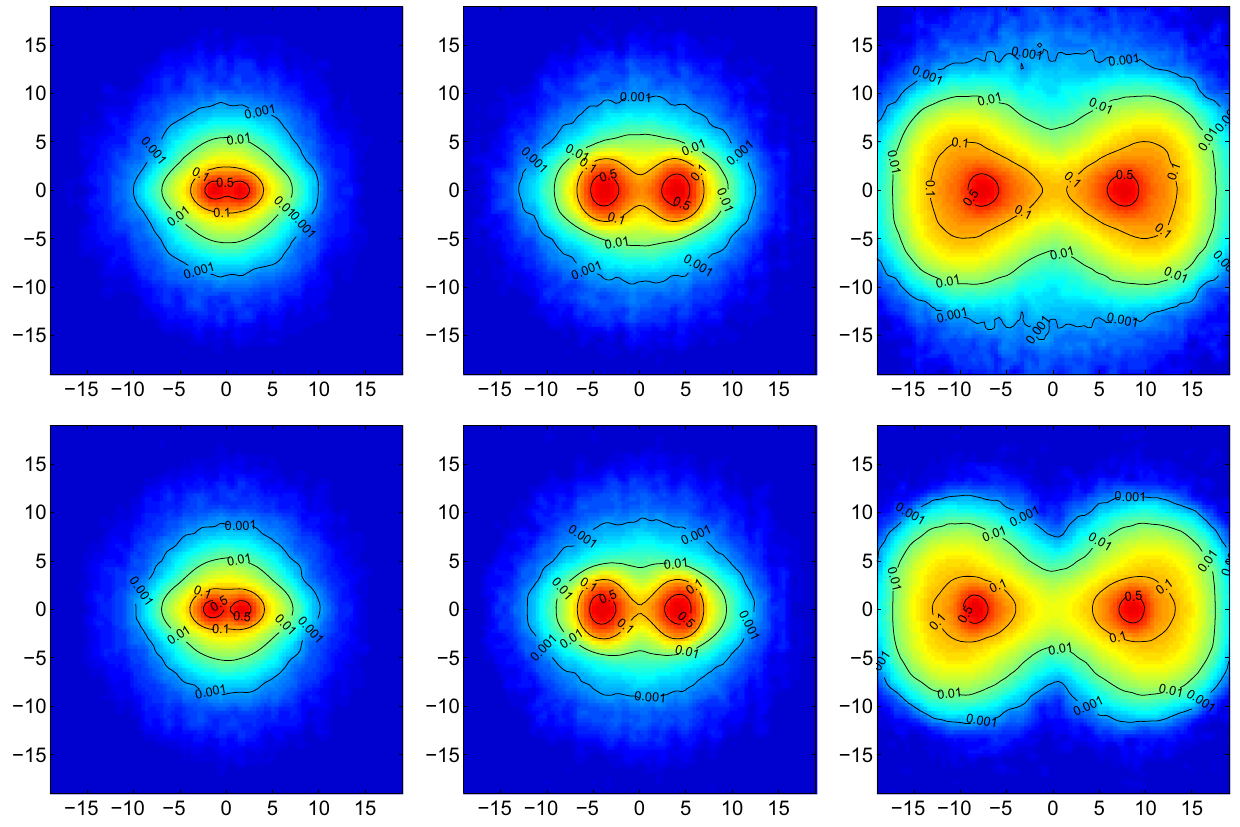
Fig. 5 The difference in the post-collision mass distributions of fast symmetric galaxy cluster collisions with weakly scattering DM and k = 1 . 5. The top row shows the post-collision mass distribution with weakly scattering DM and the bottom row shows the same for standard CDM, for comparison. Three post-collision stages are shown charac- terized by inter-cluster separation in units of r c : early stage where the